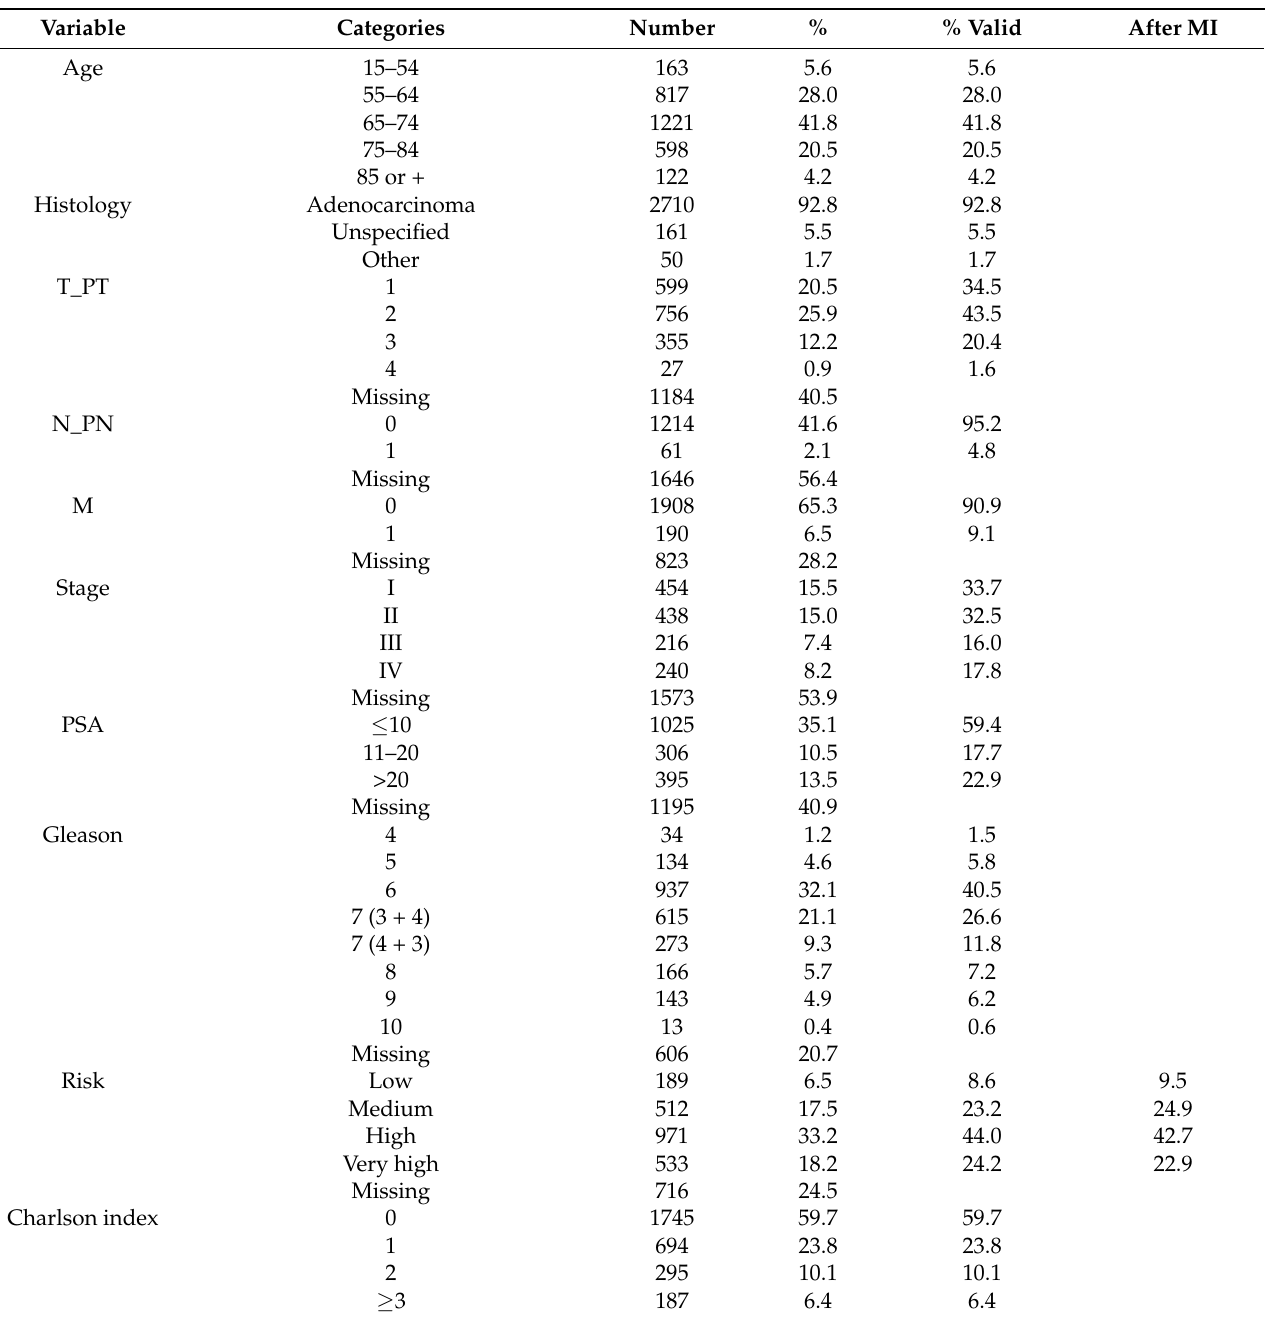
Table 1. Clinical description of prostate cancer cases diagnosed in Mallorca between 2006–2011 (N =